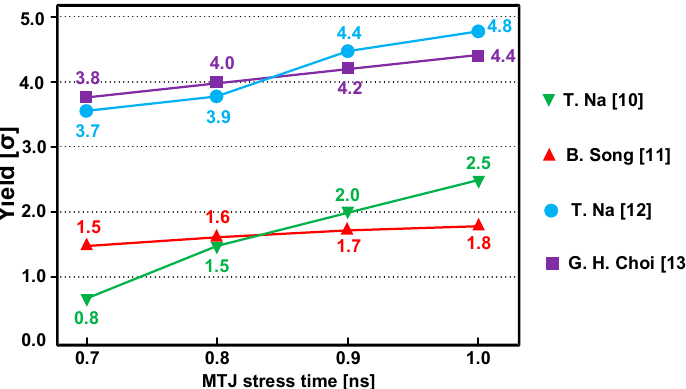
Figure 6. Restore yield of state-of-the-art NVFFs relative to the MTJ stress time during the sensing mode at SS corner. For this simulation, V DD of 0.6 V is used.